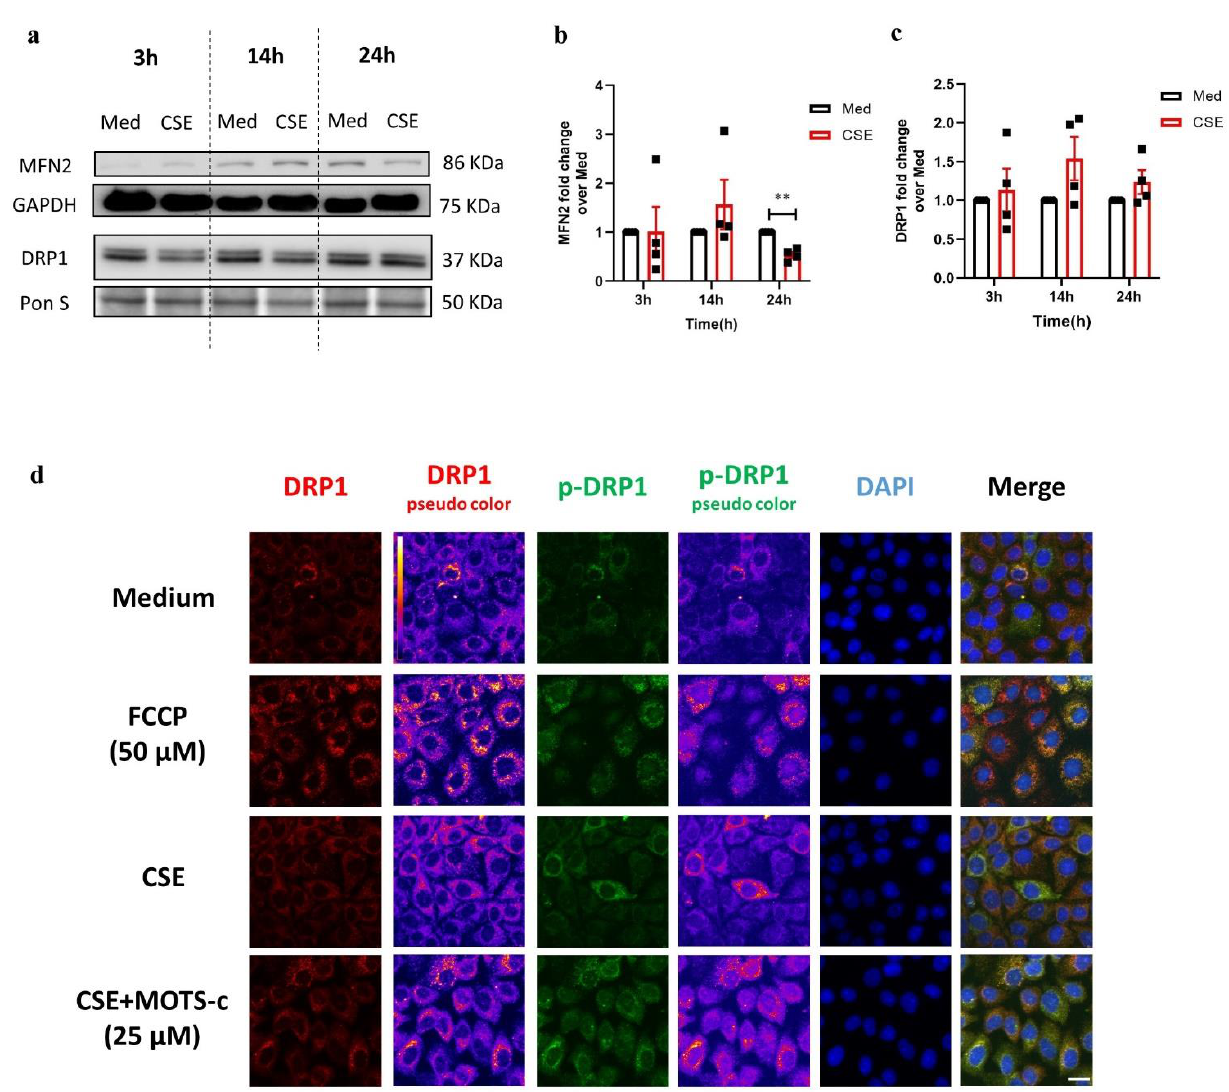
Figure 3. Stimulation with cigarette smoke affects expression of mitochondrial fission/fusion-associated proteins. ( a ) Immunoblots representing protein expression of fusion-marker mitofusion 2 (MFN2) and fission-marker dynamin-related protein 1 (DRP1) in 16HBE cells incubated with medium (Med) or cigarette smoke extract (CSE) for 3 h, 14 h, and 24 h. Fold change of protein levels of ( b ) MFN2 and ( c ) DRP1 in CSE-stimulated conditions over the medium control. The data are represented as mean ± SEM of four independent experiments with triplicate samples (N = 4). Normalization of protein expression was performed using GAPDH or Ponceau S (Pon S) staining. Representative Western blot images are selected and depicted of one replicate representing the changes of all replicates as quantified in the corresponding graph. Significant differences were calculated by multiple t -test and with the Holm – Sidak post hoc correction test (** p < 0.001). ( d ) Immunofluorescence imaging of treated cell co-stained with anti-DRP1 (red) and anti-phospho-DRP 1 at serine 616 (green) antibodies in combination with 4 ′ ,6-diamidino-2-phenylindole (DAPI) nuclear staining in blue. 16HBE cells were either incubated with for 28 h with medium and CSE or CSE for 24 h followed by 4 h treatment with 25 µM MOTS-c and 24 h medium, with 4 h carbonyl cyanide-p-trifluoromethoxyphenylhydrazone (FCCP). False color-coded image columns are shown here to depict differences in staining intensity. Merged images have been gamma-corrected to visualize weak signals without losing the highlights. The scale bar is equivalent to 20 µm.